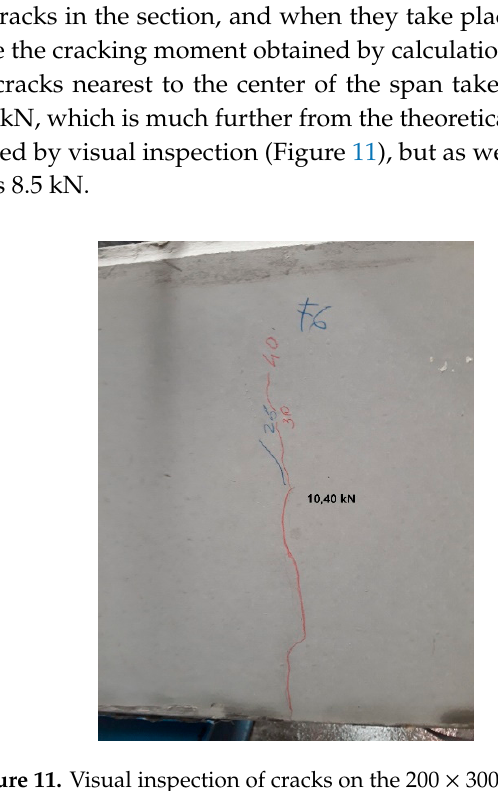
Figure 11. Visual inspection of cracks on the 200 × 300 mm beam.